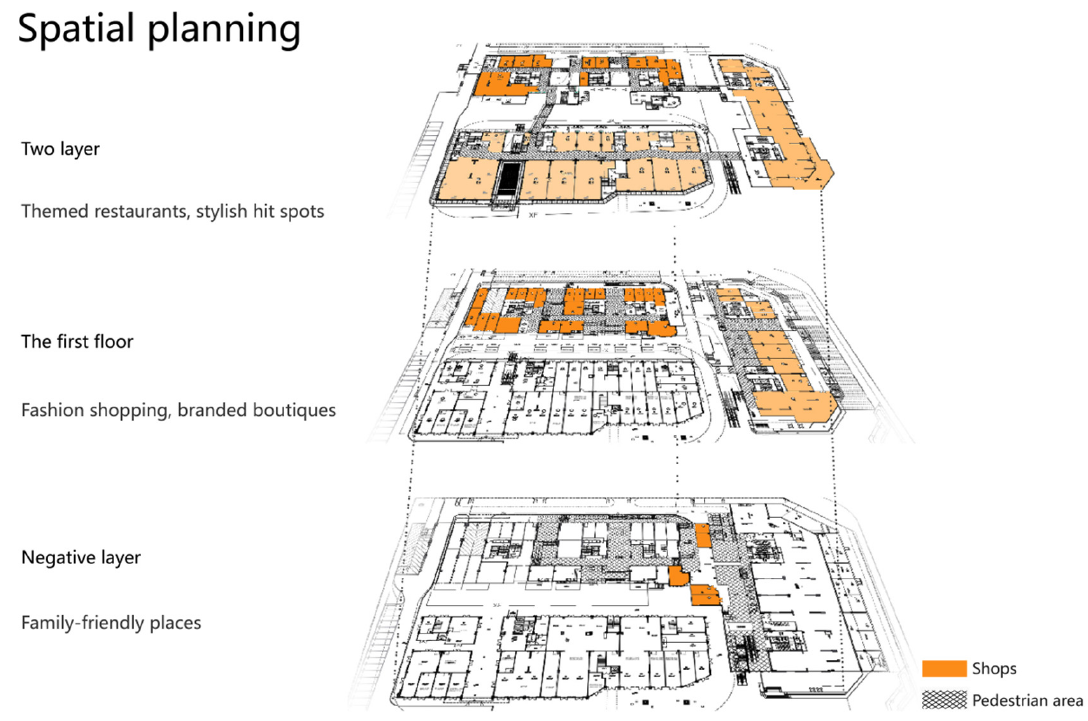
Figure 2. Overall plan of Nanpu Times.